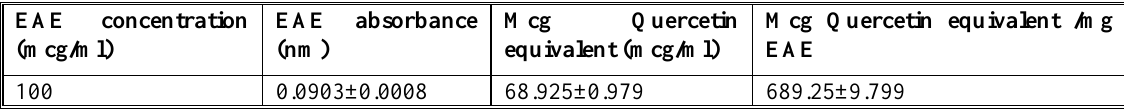
Table 5. The total flavonoid content of EAE of Iraqi C.grandiflora .